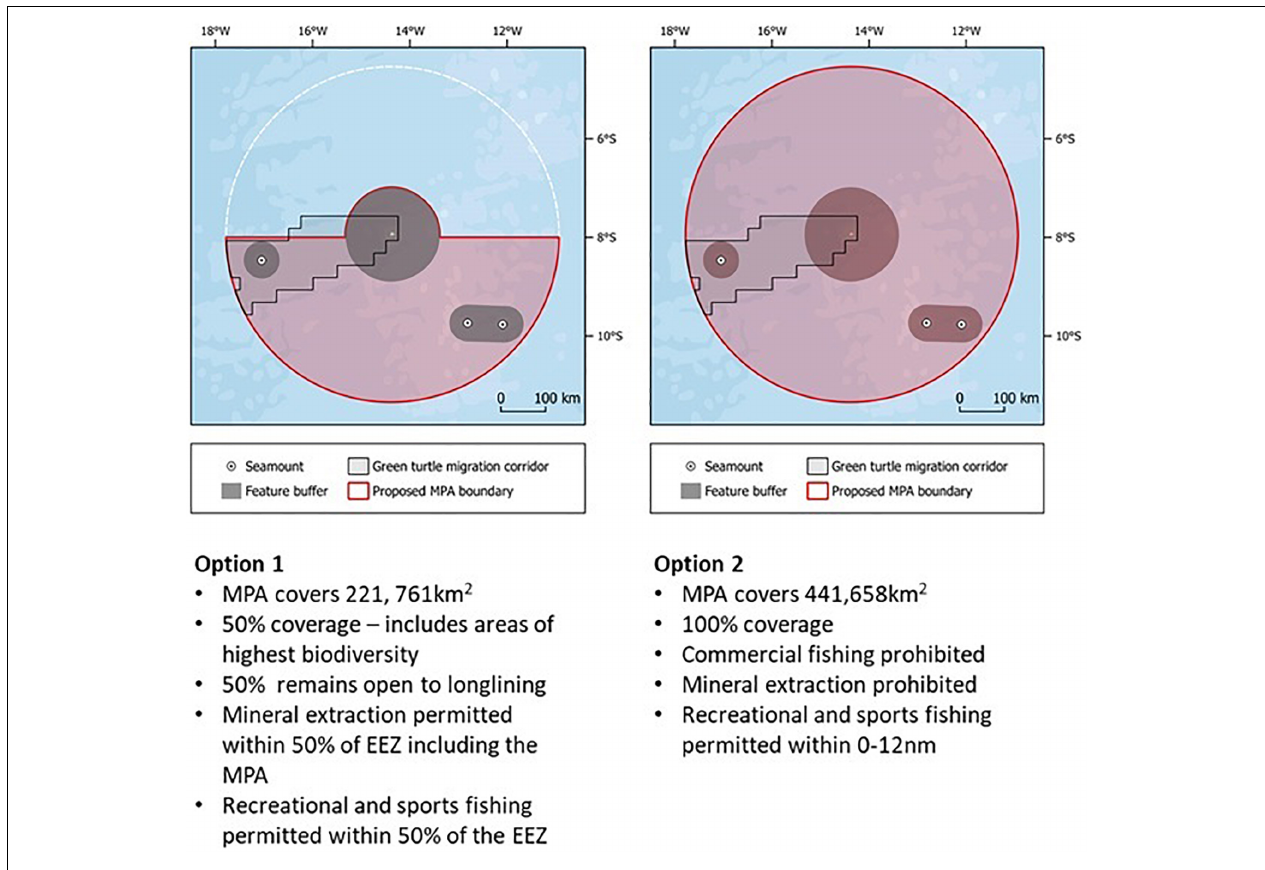
FIGURE 1 | Management options in the MPA design phase for the Ascension Island